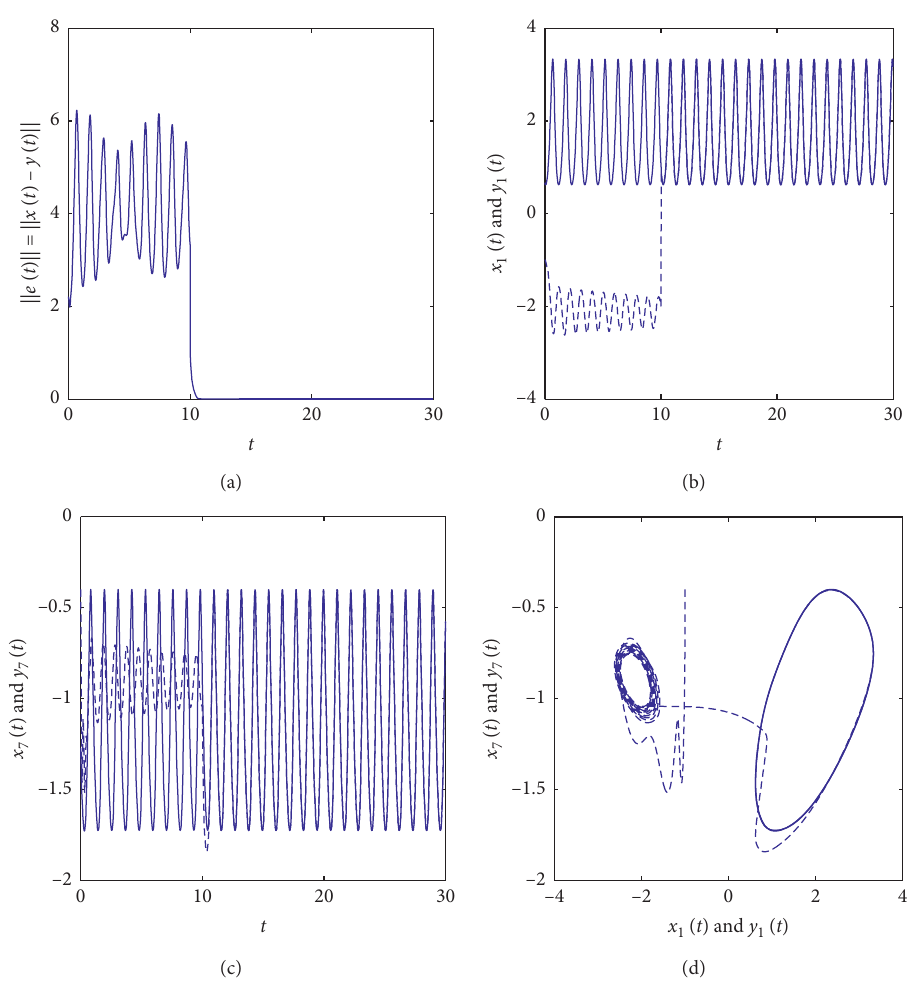
� 20 in the slave system (8) to e norm of the error e versus time. 2 ( t ) and y ( t ) versus x ( t ) and y ( t ) 7 7 1 1